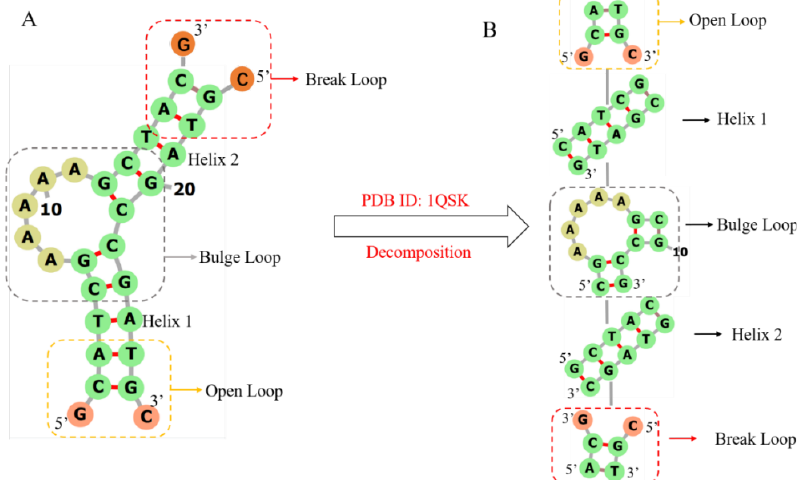
Figure 10. The workflow of decomposing DNA 1QSK to five SSEs. Break loop, bulge loop, and open loop are marked by red, grey, and yellow rectangular boxes, respectively. ( A ) The secondary struc- ture of DNA 1QSK. ( B ) All the SSEs, which together form a secondary structure tree (SST) of DNA 1QSK, including two helices and one open loop with 2D structure “.(()).”, a bulge loop with 2D structure “(( . . . ..(())))”, and a break loop with 2D structure “((.&.))”. DNA 2D plots are generated using Forna [37].